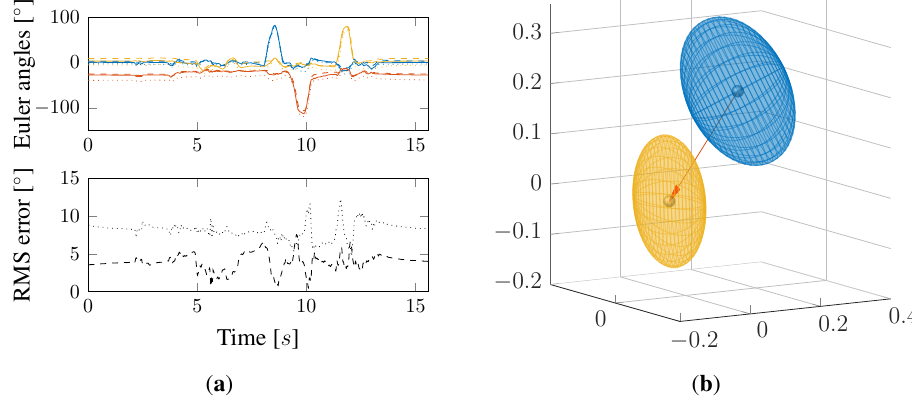
Figure 10. Exemplary calibration procedure measurement (90 ◦ rotation in each direction) and resulting errors compared to the ADIS reference system. ( a ) Non-calibrated (dotted) and calibrated (dashed) orientation estimation; ( b ) error distribution before (blue) and after (yellow)